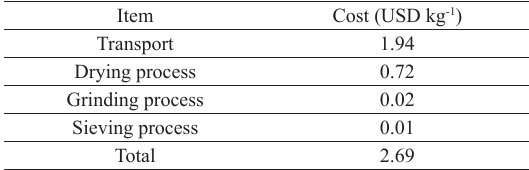
Table 8. Laboratory production costs for the corrosion inhibitor.